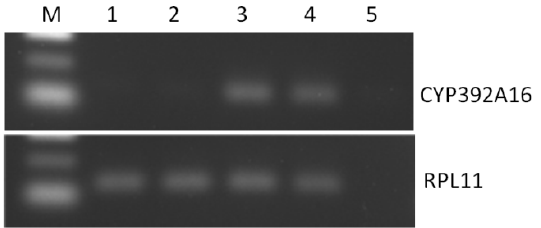
Figure 2. Confirmation of CYP392A16 expression in transgenic Drosophila melanogaster by PCR amplification of cDNA. Lanes 1 and 2 represent biological replicates of progeny from the cross yw x HR-GAL4 (not expressing CYP392A16) while lanes 3 and 4 are progeny from the cross UAS-TuCPR32; UAS-CYP392A16.71 × HR-GAL4, while lane 5 is a non-template negative control. The top gel represents products amplified with the primers CYP392A16F/R (Table 1), while the bottom gel represents products amplified with primers for the RPL11 housekeeping gene.